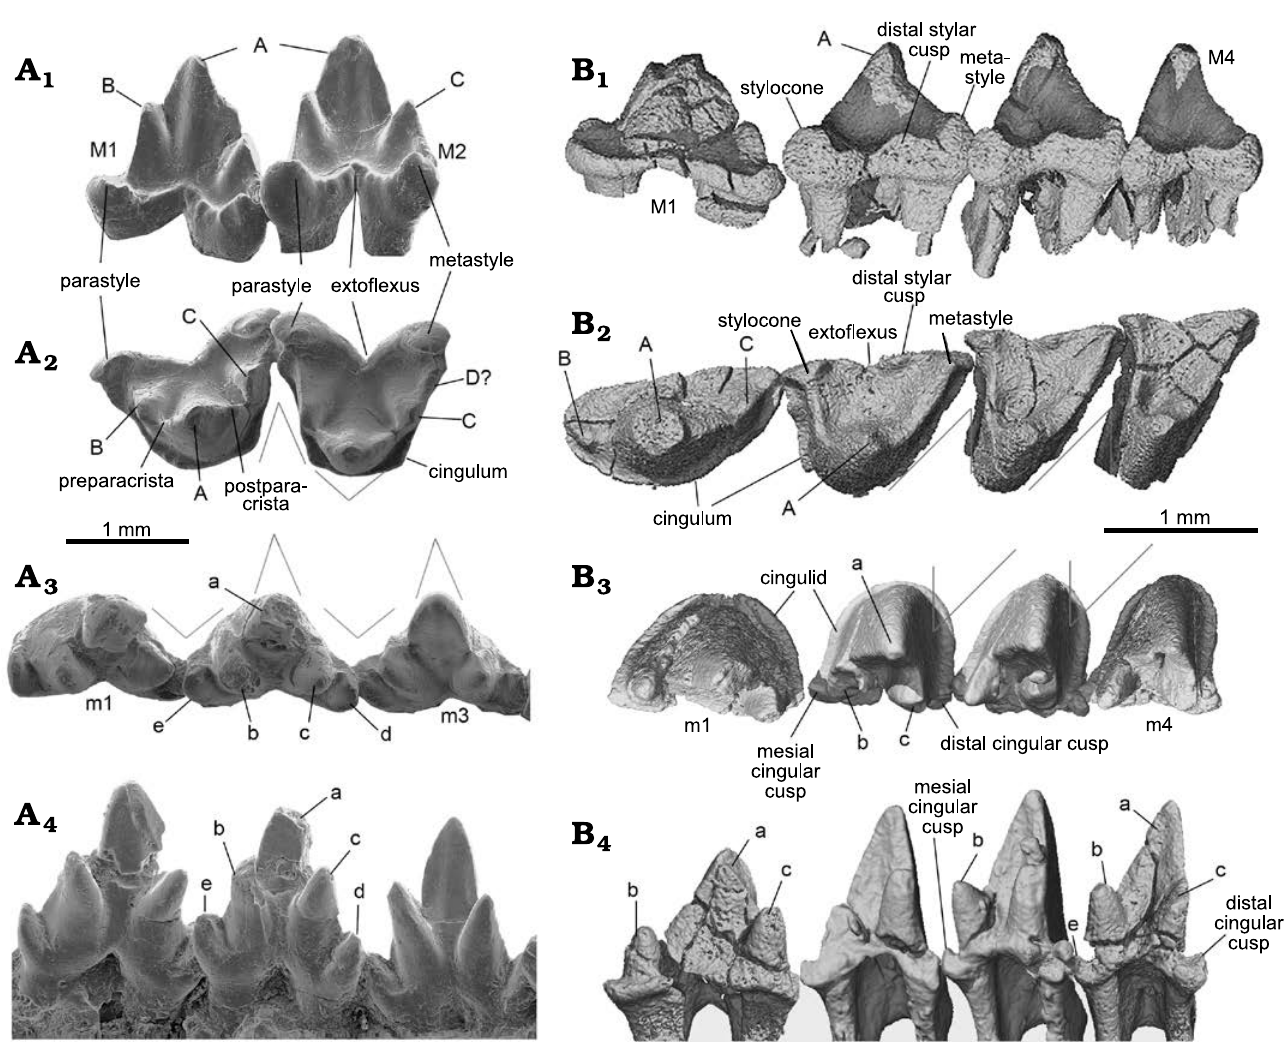
Fig. 7. Comparison of molars between of Origolestes and Lactodens . A . Origolestes lii Mao, Hu, Li, Wang, Chase, Smith, and Meng, 2020 (IVPP V13604) from Lower Cretaceous Lujiatun beds of the Yixian Formation of the Lujiatun locality, Beipiao County, Liaoning Province, China; upper molars (M1–M2) in buccal (A 1 ) and occlusal (A 2 ) views; lower molars (m1–m3) in occlusal (A 3 ) and lingual (A 4 ) views (modified from Mao et al. 2020). B . Lactodens sheni Han and Meng, 2016 (ZGY0053) from Aptian, Lower Cretaceous Jiufotang Formation of Dapingfang, Caoyang City, Liaoning Province, China; upper molars (M1–M4) in buccal (B 1 ) and occlusal (B 2 ) views; lower molars (m1–m4) in occlusal (B 3 ) and lingual (B 4 ) views. Image in B 1 has been vertically reversed for convenience of comparison. The lower teeth (m1–m4) in B 3 and B 4 were composite from better preserved left m2–m3 (reversed) and right dentitions (m1, m4). The angular lines indicate the symmetrical ( O. lii ) and asymmetrical ( L. sheni ) crown outline and the